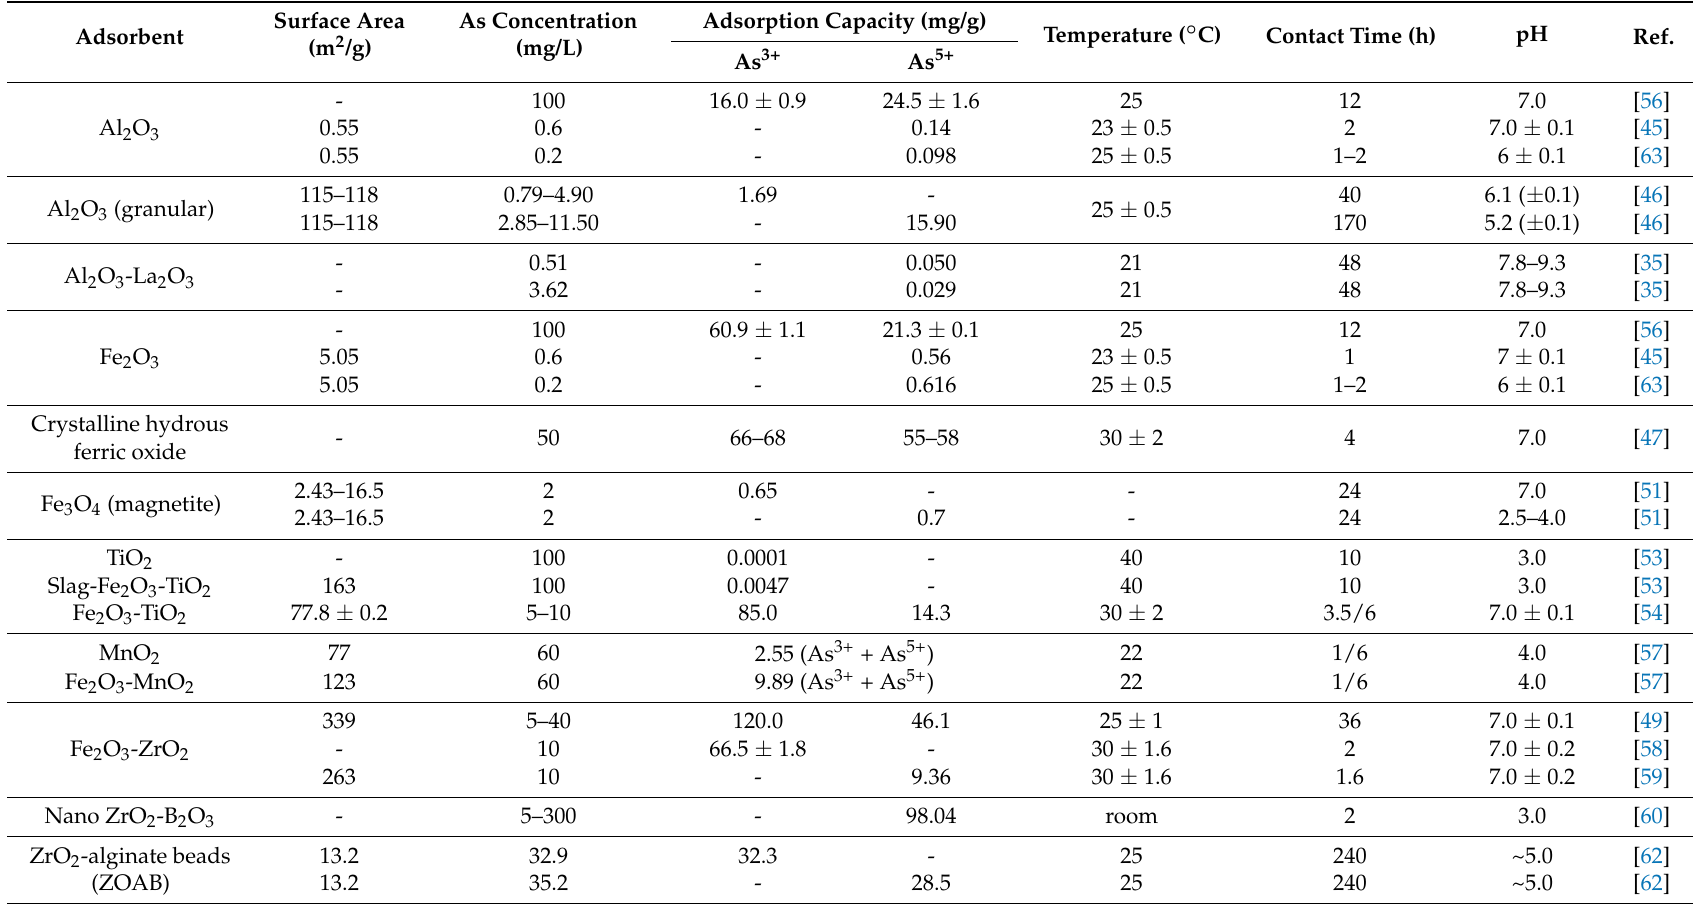
Table 1. Sorption properties of metal oxide-based adsorbents for arsenic oxyanions